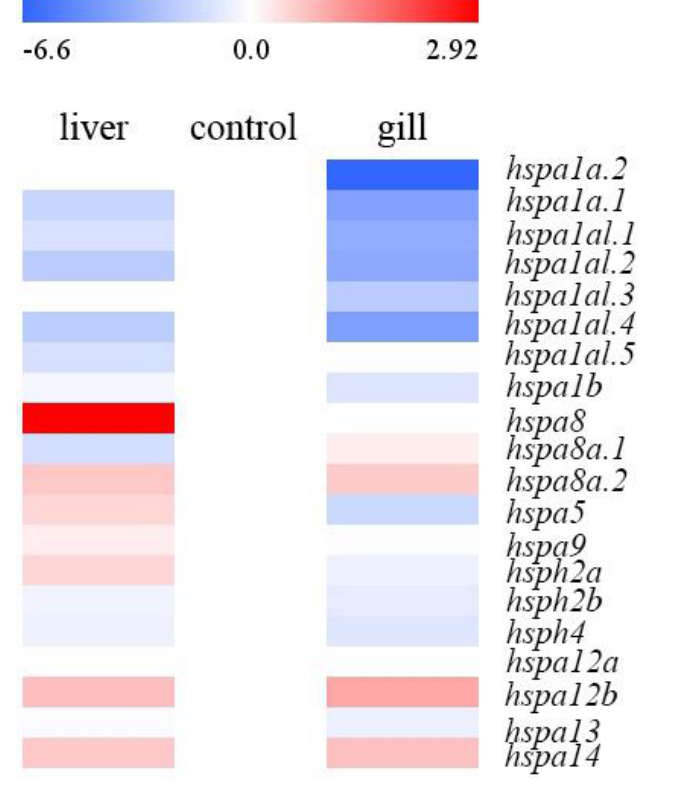
Figure 4. Expression profiles of B. pectinirostris Hsp70 genes in different tissues. The expression level of each gene was compared against the data of control (0 h). Log2 based fold change in FPKM values was used to create the heat map. FPKM: fragments per kilobase of exon per million fragments mapped.